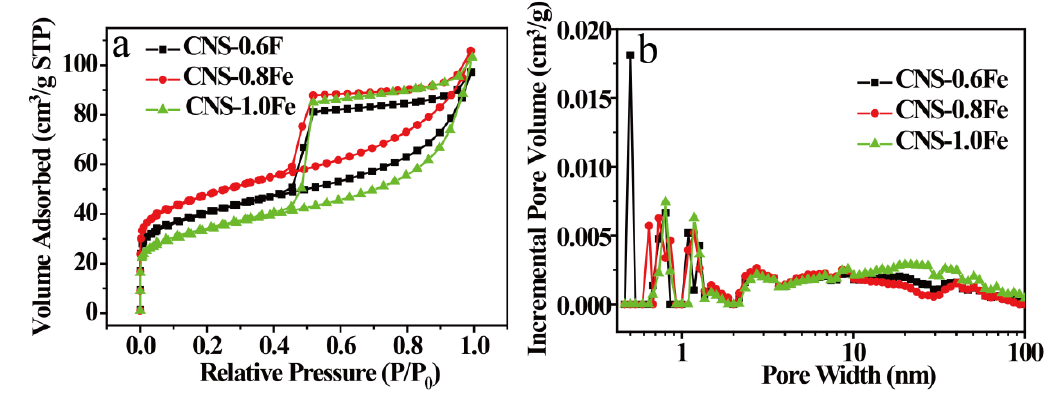
Figure 5. ( a ) N 2 adsorption and desorption isotherms of CNS – 0.6Fe, CNS – 0.8Fe and CNS – 1.0Fe. ( b ) Table 1. Surface area, porosity of Table 1. Surface area, porosity of CNSs.